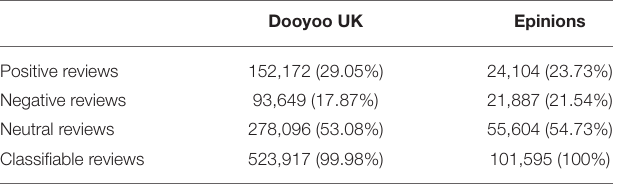
TABLE 2 | The fraction of positively, negatively charged, and neutral reviews.